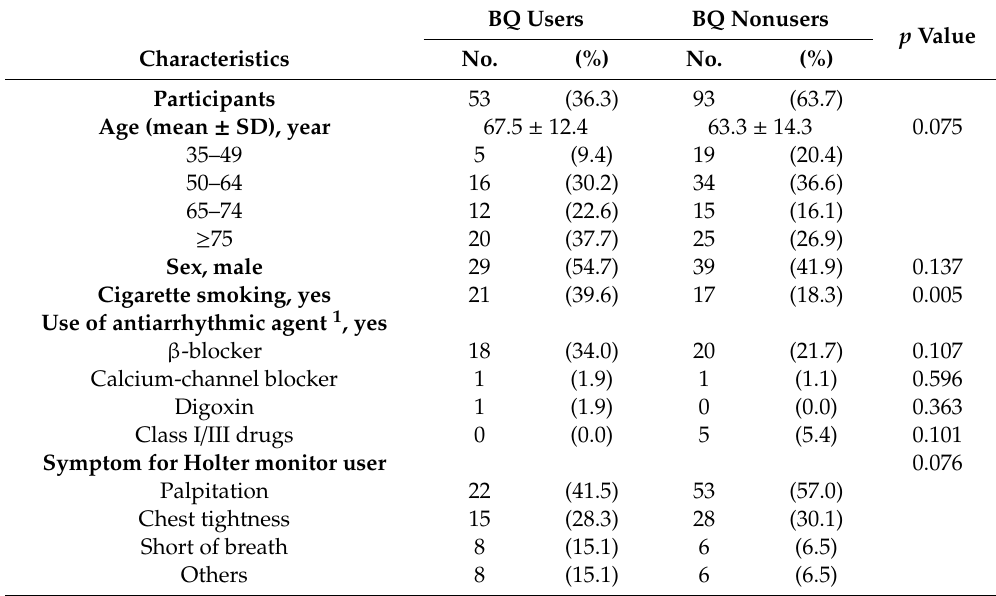
Table 1. Demographic and clinical characteristics associated with betel-quid (BQ) use among Holter monitor patients. BQ Users BQ